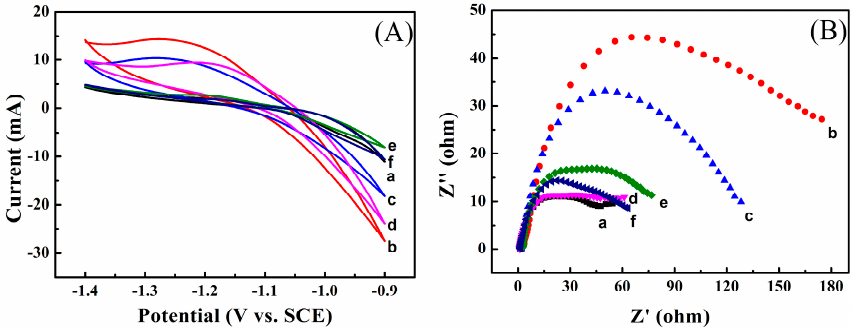
Figure 5. CV ( A ) and EIS ( B ) of the zinc electrode in the aqueous electrolyte containing different concentrations of sodium propionate (a: 0.05 M; b: 0.10 M; c: 0.15 M; d: 0.20 M; e: 0.25 M; and f: 0.30 M).